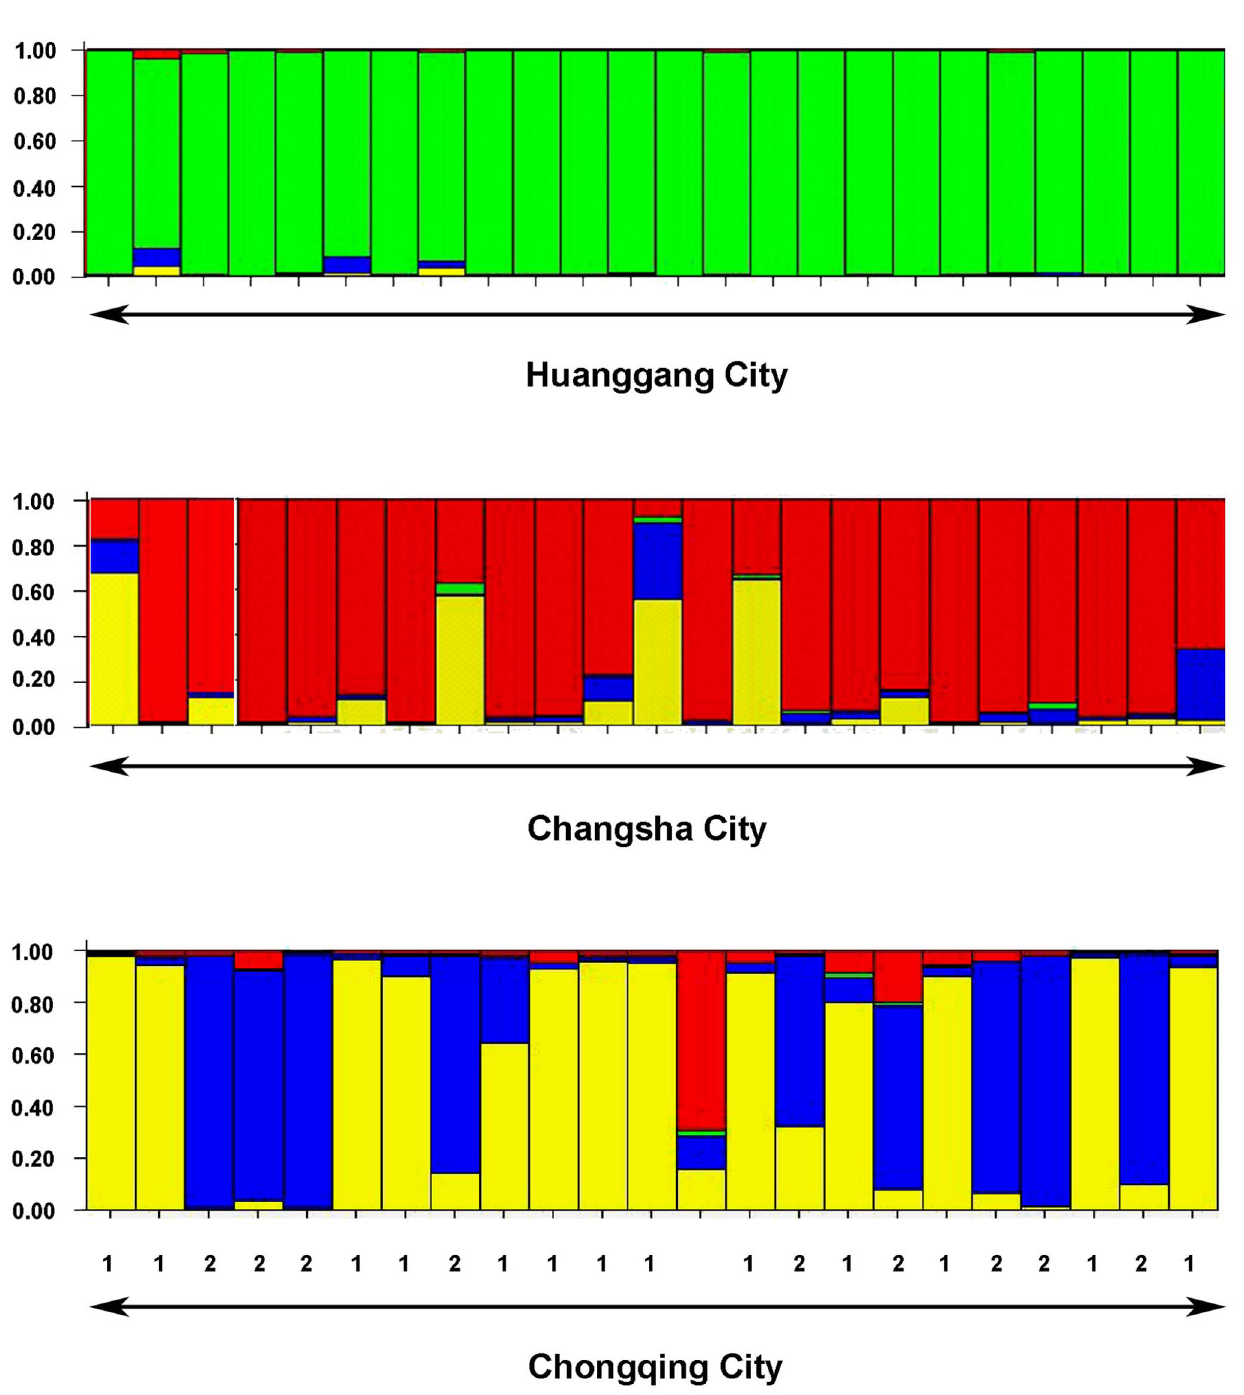
Figure 2. Assignment of individuals (each representing a colony) sampled from three cities to genetic clusters. Columns represent colonies, each color represent a different genetic cluster defined by STRUCTURE ( K =4). The colors in each column represent the likelihood with which a colony is assigned to each genetic cluster. The numbers (1 and 2) in this figure represent the colonies assigned to the Chongqing-1 population and the Chongqing-2 population, respectively.